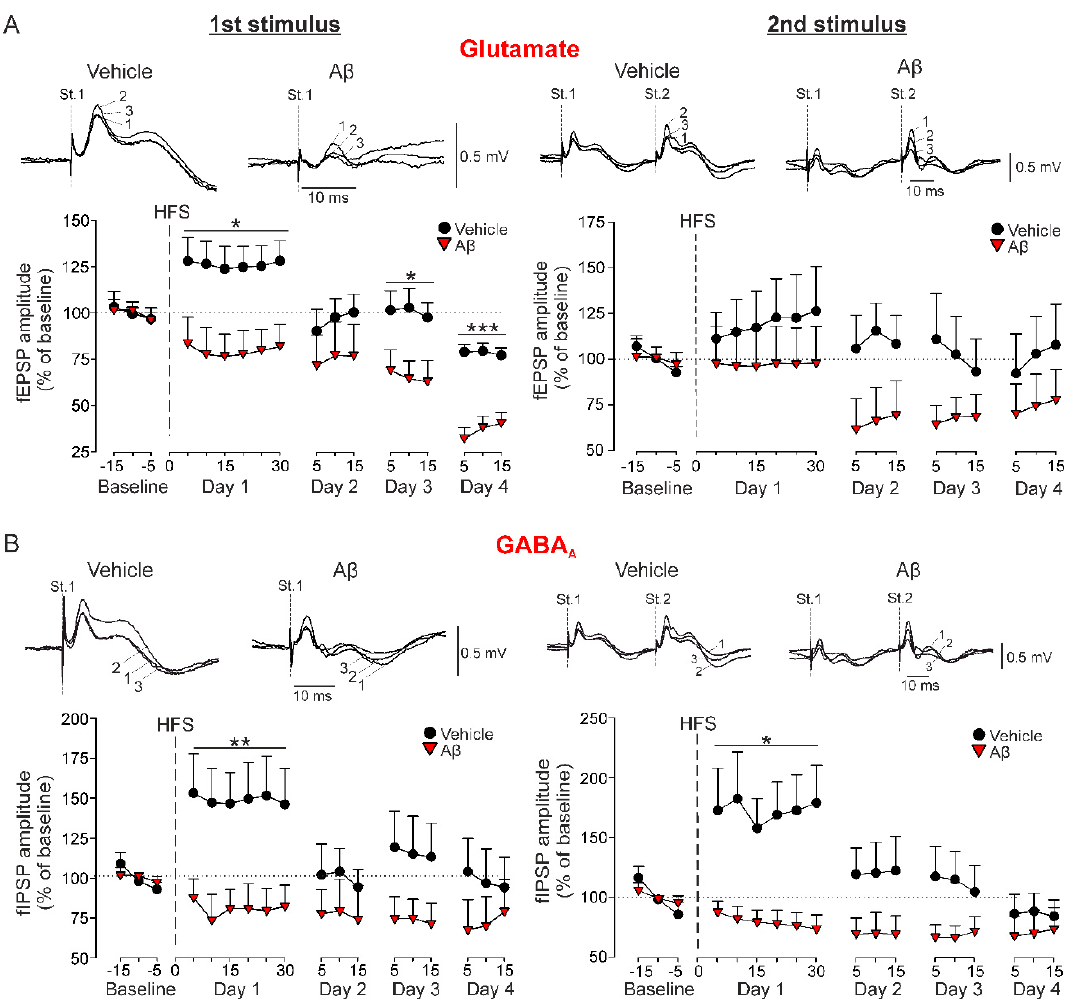
Figure 2. Long-term synaptic plasticity in behaving mice. The amplitude of the field postsynaptic potentials (fPSPs) evoked in vehicle and A β -injected mice by the first (St. 1) and second (St. 2) stimulus of paired-pulse stimulation was examined before (Baseline) and after (Day 1–Day 4) LTP induction through a HFS session. ( A ) Representative examples (averaged five times) of fEPSPs evoked before the HFS session (baseline; 1), 10 min after HFS (2) and 48 h after HFS (3) are shown above. Below, LTP of fEPSPs (mean ± SEM). * p < 0.05, *** p < 0.001 vs. vehicle. ( B ) Representative examples (averaged five times) of GABA A -dependent fIPSPs evoked in vehicle and A β -injected mice are shown above. Below, LTP of fIPSPs (mean ± SEM). * p < 0.05, ** p < 0.01 vs. vehicle.